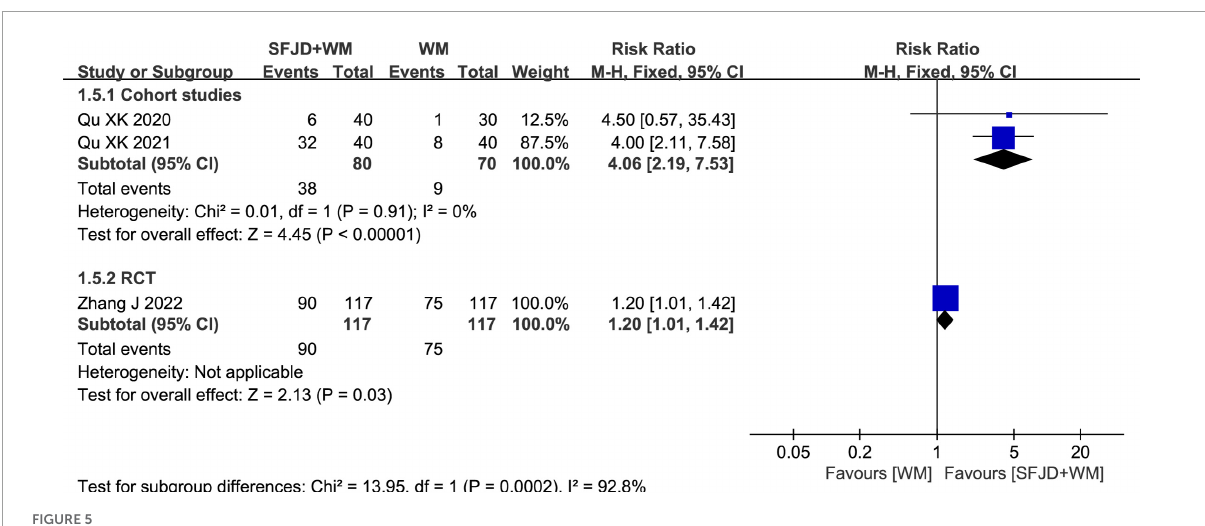
FIGURE5 Meta-analysis regarding the cure rate between SFJD + WM and WM groups among COVID-19 cases.